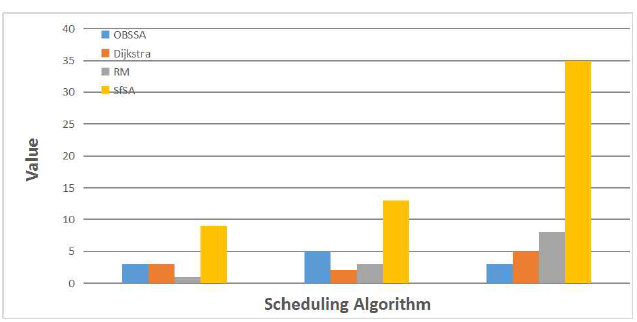
Figure 8. An example of one test case.